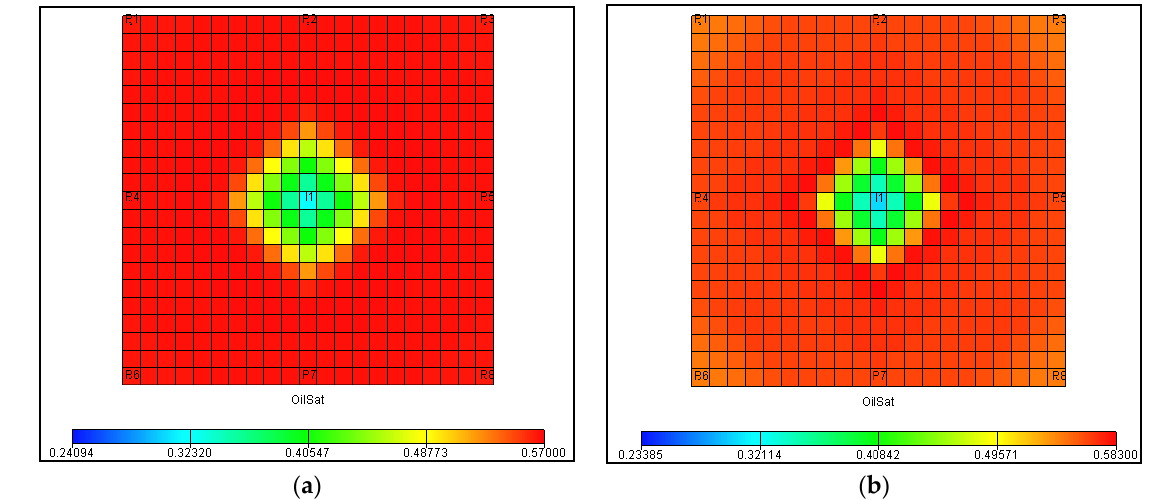
Figure 6. Residual oil saturation diagram on January: ( a ) Darcy seepage; ( b ) non-Darcy seepage.